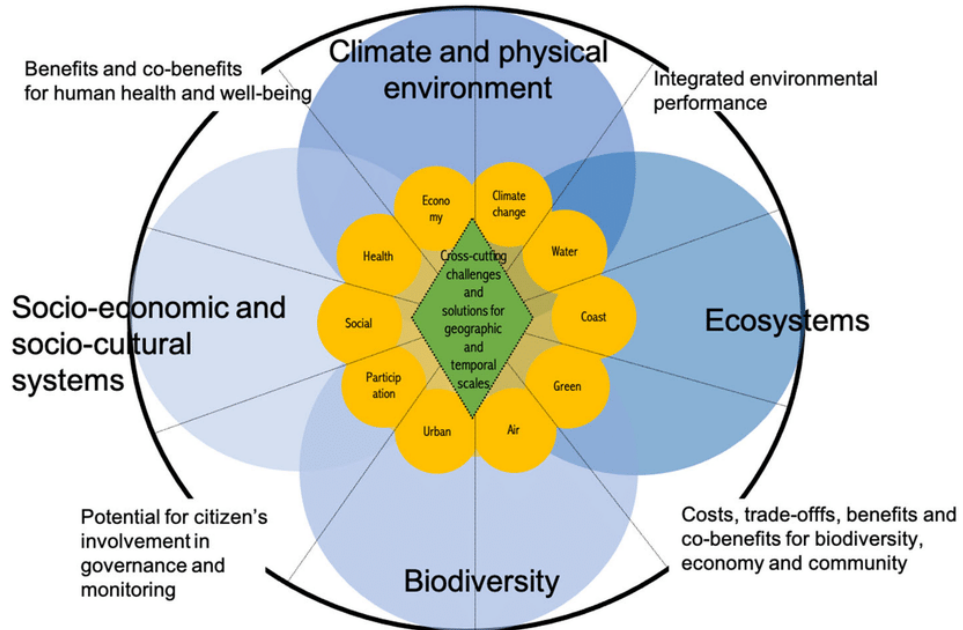
Figure 2. This is a wide figure. Figure 1. A summary interpretation of possible benefits of Nature-Based Solutions (NBS) in light of the sustainable and resilient evolution of just cities (redrawn and adapted from Table 2. This is a wide table.